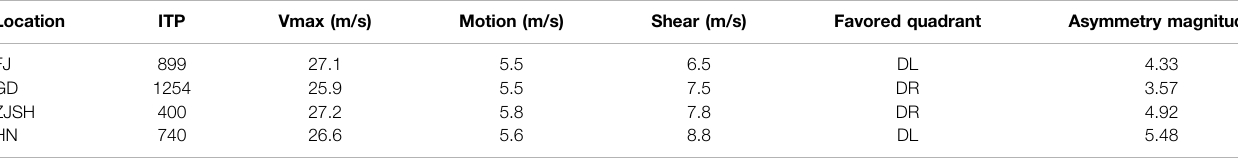
TABLE 4 | The favored quadrant and the magnitude of lightning asymmetry (relative to shear) as a function of landing locations. V max , shear and motion are the mean values during the 48-h landfall period. Location